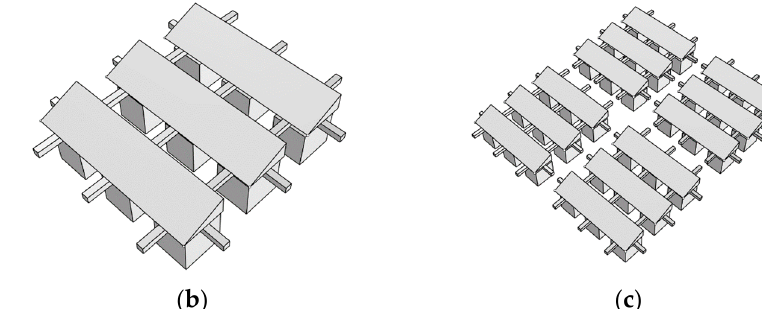
Figure 1. Geometry of a floating solar power farm used in the experiment: ( a ) floating body; ( b ) unit; ( c ) block.